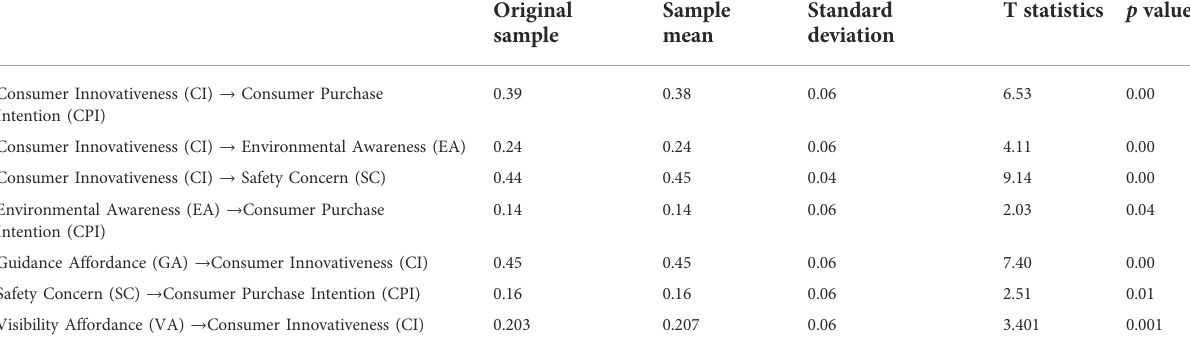
TABLE 5 Path coef fi cient through Smartpls Bootstrapping.